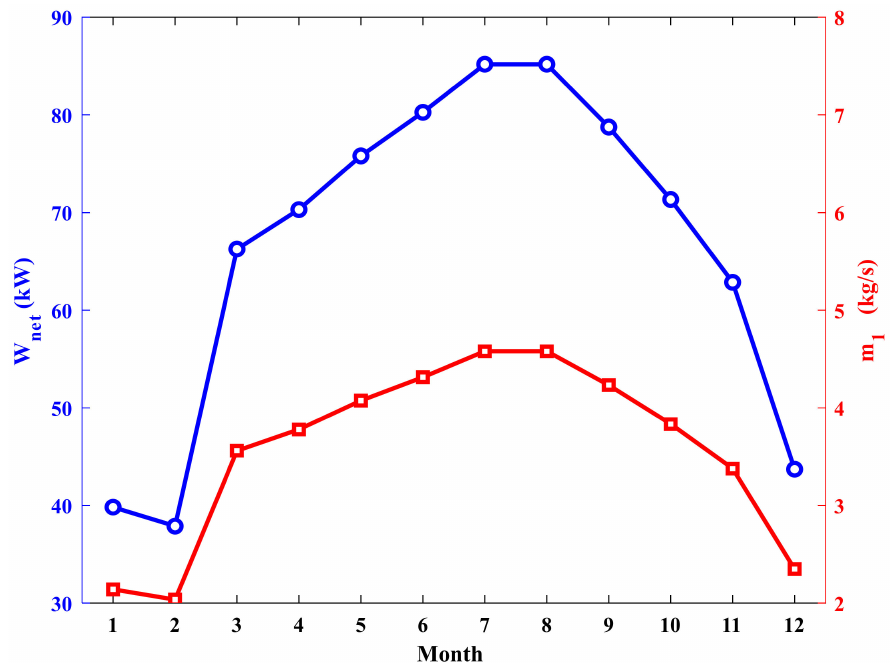
Figure 16. Monthly net power output of the CHP system, and the monthly evaporator mass flow rate in